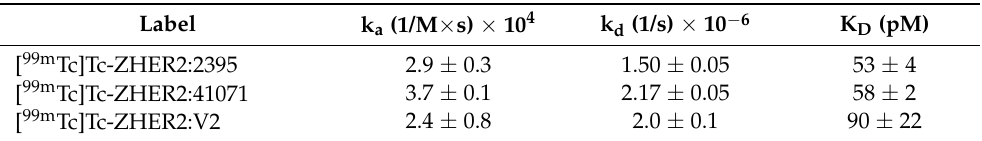
Figure 5. Interaction Map of ( A ) [ 99m Tc]Tc-ZHER2:2395, ( B ) [ 99m Tc]Tc-ZHER2:41071. and ( C ) [ 99m Tc]Tc-ZHER2:V2 binding to HER2-expressing SKOV3 cells. Input data are obtained from LigandTracer measurement of cell-bound activity during association of labelled compounds to and dissociation from SKOV-3 cells. InteractionMap finds individual 1:1 interactions in the input data whose weighted sum explain the observed binding process. The individual interactions are displayed as coloured spots in a ka/kd plot with their colour representing their weight: warmer colours represent more abundant interactions. Binding was measured at three different concentrations: 0.33, 1, and 3 nM. The measurement was performed in duplicates.